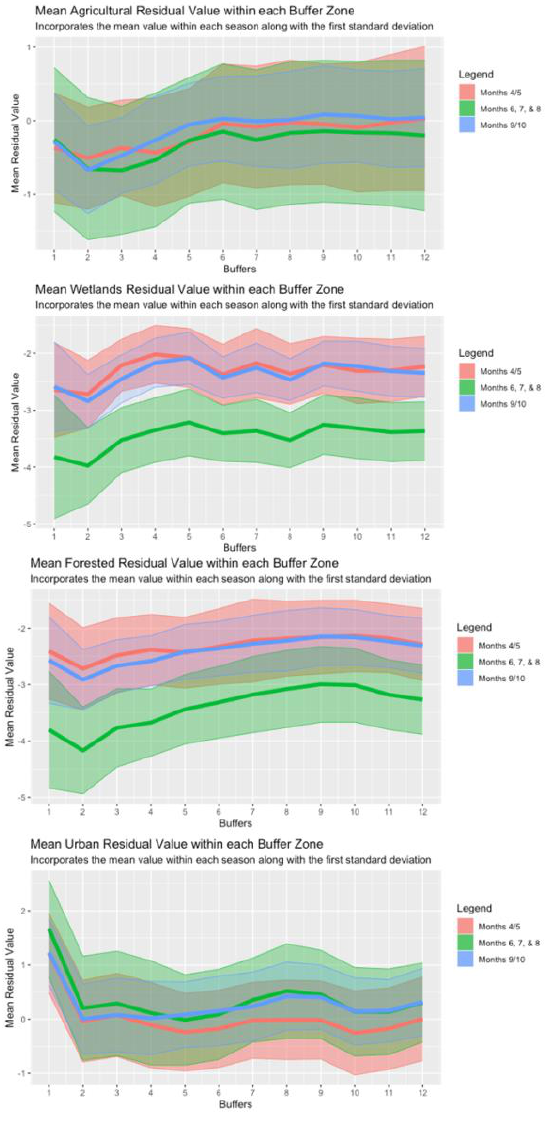
Figure 8 . The mean and first standard deviation residual value of each land cover within each season for each buffer away from the central urban